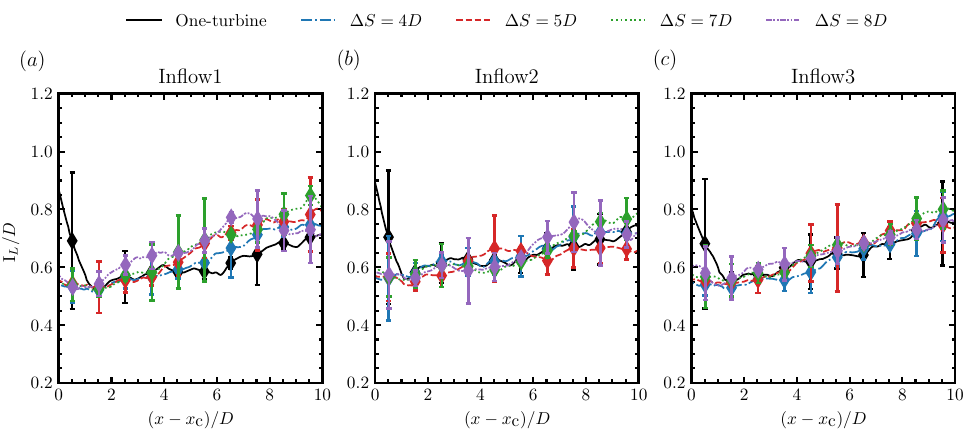
Figure 16. Streamwise variations of the integral length scale computed using Equation (7) for ( a ) inflow1, ( b ) inflow2 and ( c ) inflow3, respectively. It is noticed that the integral length scale is filtered in the streamwise direction with the filter scale D , with the error bar showing the stand deviation of the subfilter